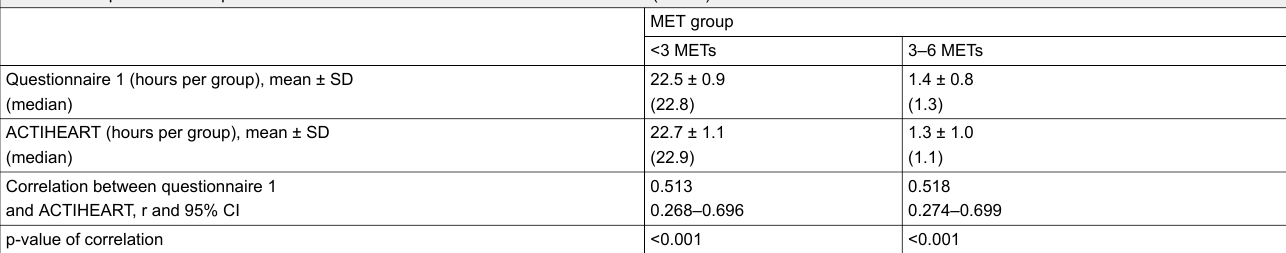
Table 2: Comparison of the questionnaire 1 data with the ACTIHEART measurements (n =